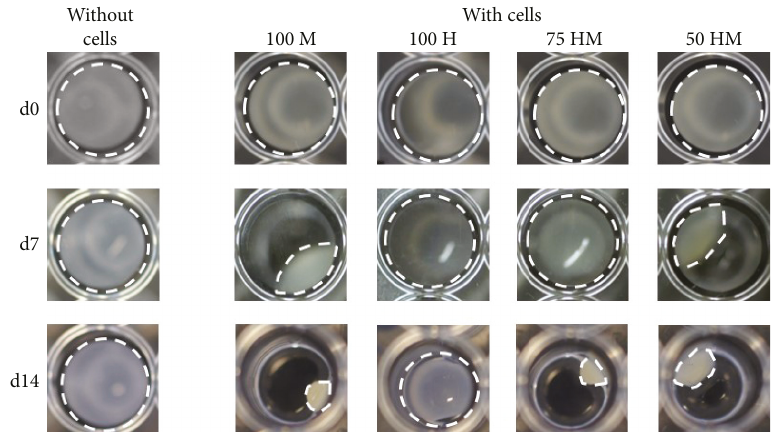
Figure 2: MSC mediated shrinkage of PRP gels. PRP gels (120 μ l) were seeded either with or without cells in a 96-well plate. Di ff erent types of cells were encapsulated (seeding density: 2.5 × 10 3 cells/ μ l gel): 100% MSCs (100M), 100% HUVECs (100 H), 75% HUVECs – 25% MSCs (75 HM), 50% HUVECs – 50% MSCs (50 HM). Shown are representative pictures from day 0 (d0), day 7 (d7), and day 14 (d14). White dashed lines indicate the outline of gels. Shrinkage was only observed when MSCs were present in